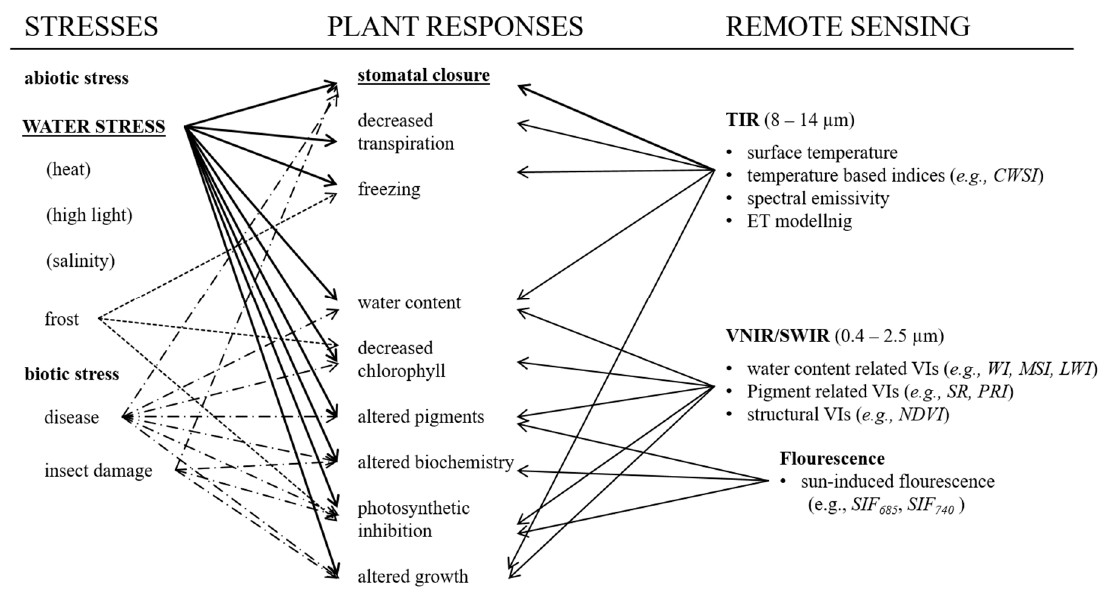
Figure 1. Most important relationships between primary plant stresses, the induced plant responses, and the multi- / hyperspectral remote sensing techniques for the detection of environmental stresses (modified after Jones and Vaughan [19]).